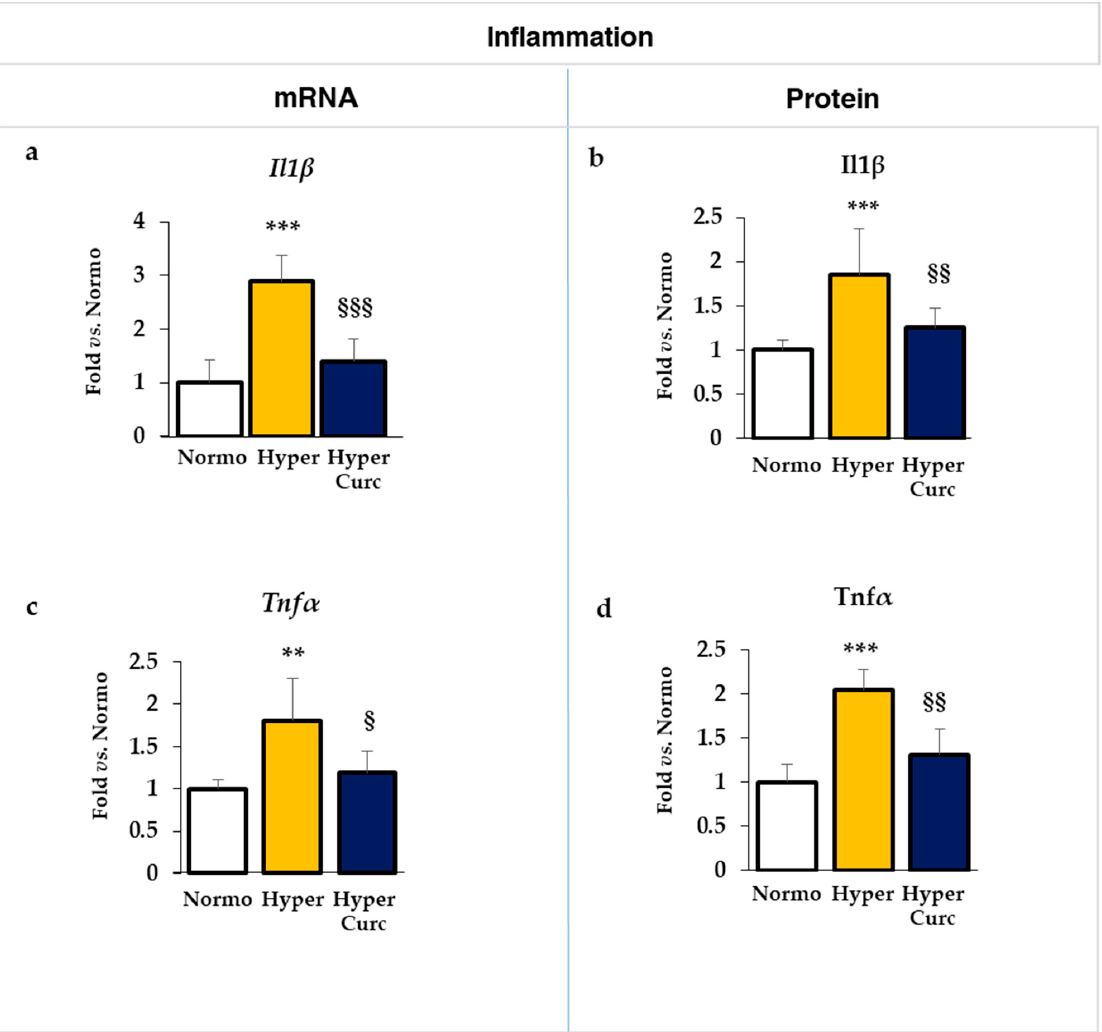
Figure 5. Curc prevents the induction of inflammation in the Hyper Gunn rat. The effect of Curc on the mRNA ( a,c ) and protein ( b,d ) level of Il1 β /Il1 β (interleukin 1beta – a , b ) and Tnf α /Tnf α (tumor necrosis factor-alpha, c , d ) were evaluated by RTqPCR and ELISA, respectively. With white bars—untreated normobilirubinemic (Normo) Gunn pups; yellow bars— untreated hyperbilirubinemic rats (Hyper); blue bars—curcumin-treated hyperbilirubinemic pups (Hyper Curc). Data are in mean ± S.D. and expressed as fold vs. the Normo pups used as reference (=1). In each experimental group, ≥ 6 animals were studied. Statistical significance was evaluated by the one-way analysis of variance (ANOVA), followed by a Tukey–Kramer Multiple Comparisons Test when p -value < 0.05. Statistical significance: **, ***: p < 0.01 and p < 0.001 vs. Normo pups. §; §§, §§§: p < 0.05, p < 0.01, p < 0.001 vs. Hyper rats.